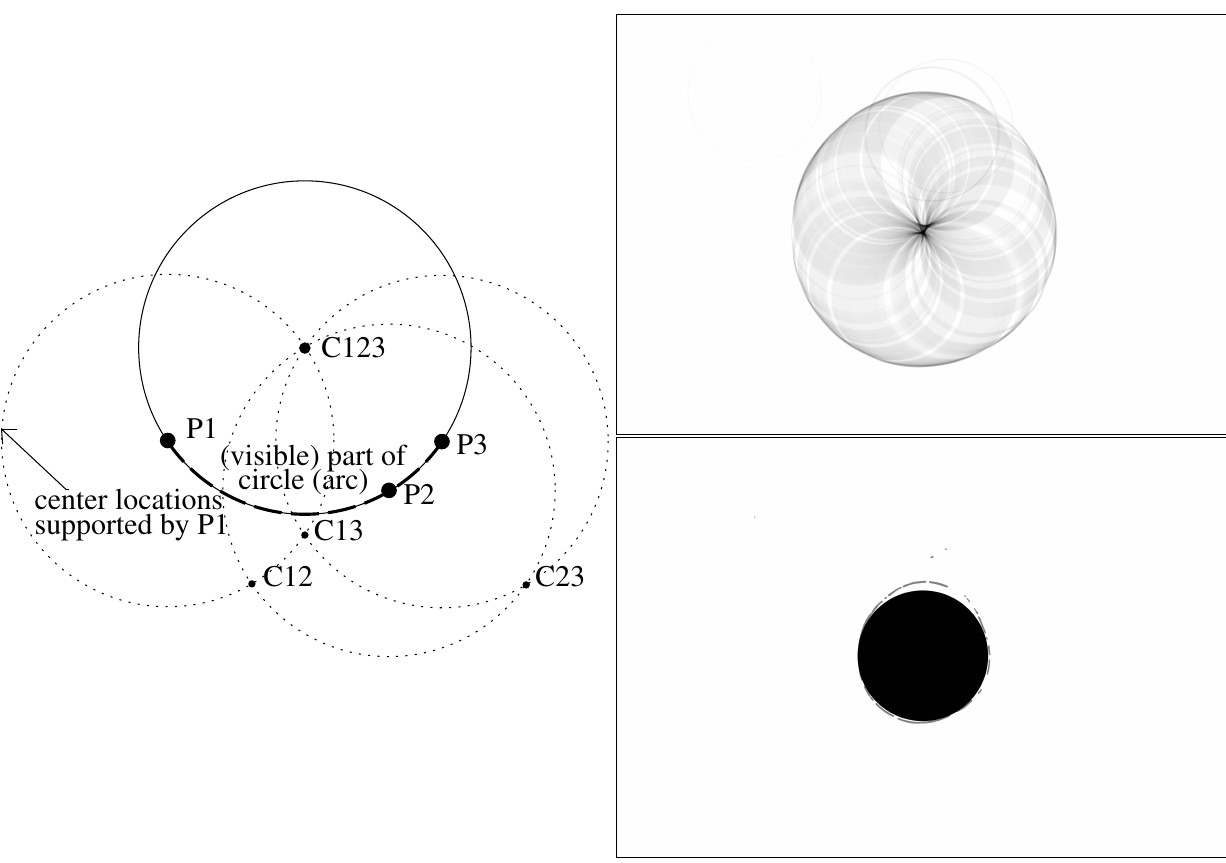
Figure 3. Circular Hough transform (left): the solid circle’s centre can be estimated from the partially visible (dashed) arc. For the three points P1, P2, P3 on the arc the possible centre locations can be constructed with fixed radius (dotted circles), and the intersection supported by most of the points (C123) be selected as most probable centre location. Top right: Hough space with the possible centre locations, derived from segmentation in Figure 2, bottom right: estimated circular ROI (black) with segmentation